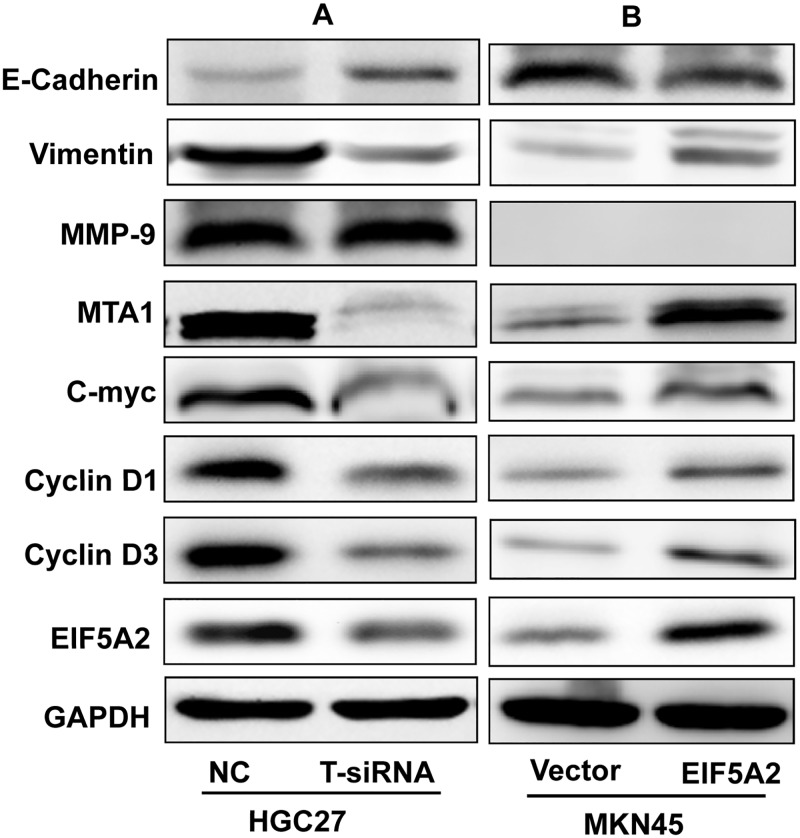
Immunoblotting analysis of protein expression after silencing or overexpressing EIF5A2 in GC cells.(A) After knockdown of EIF5A2 in HGC27 cells, E-cadherin levels were upregulated, while vimentin was downregulated accompanied by cyclin D1, cyclin D3 and C-MYC, and MTA1 downregulation. (B) Ectopic overexpression of EIF5A2 after transient transfection of EIF5A2-plasmid substantially upregulated cyclin D1, cyclin D3, C-MYC and MTA1, accompanied by downregulation of E-cadherin, while vimentin was upregulated.